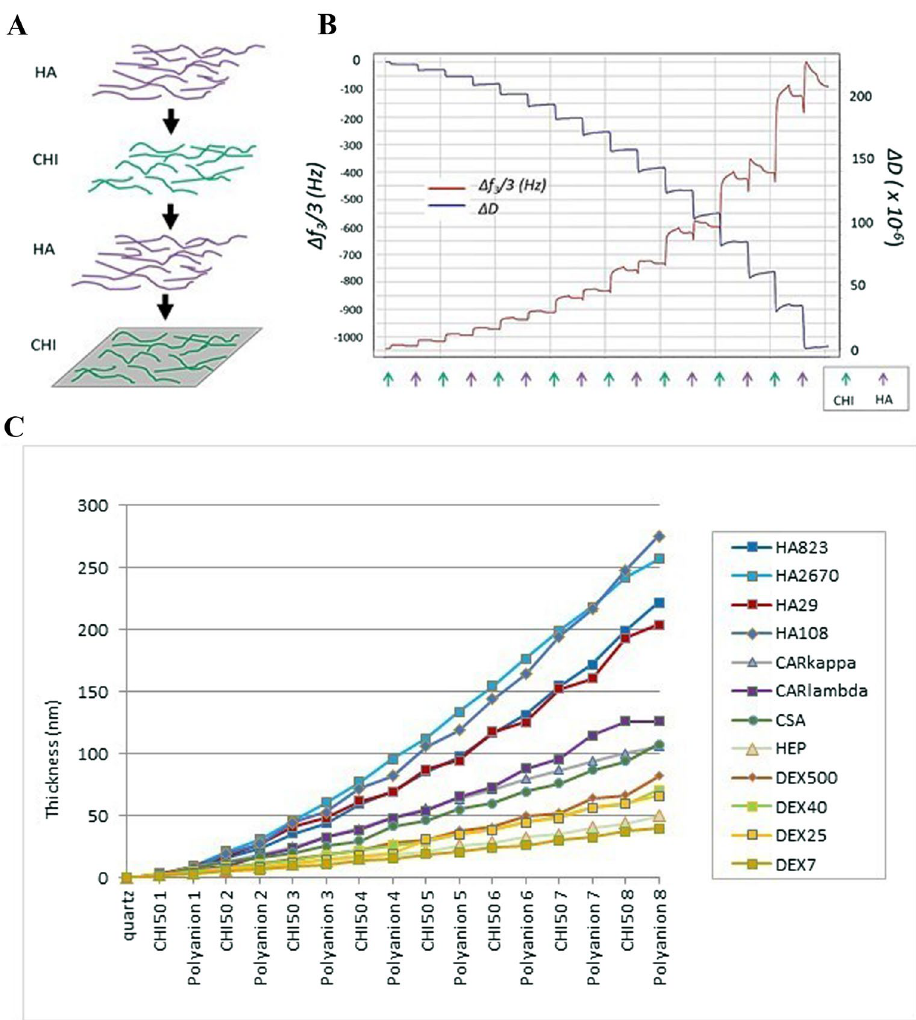
Figure 7. Film thickness determination by QCM-D. ( A ) Polyelectrolytes (chitosan, CHI, and hyaluronic acid, HA) are deposited on the crystal, where they form a multilayer film. ( B ) Growth of the film is followed by the measurements of the frequency and the dissipation variations with respect to the crystal in contact with the buffer solution only. As an example, the figure shows the measurements corresponding to the third overtone. ( C ) Film growth depending on